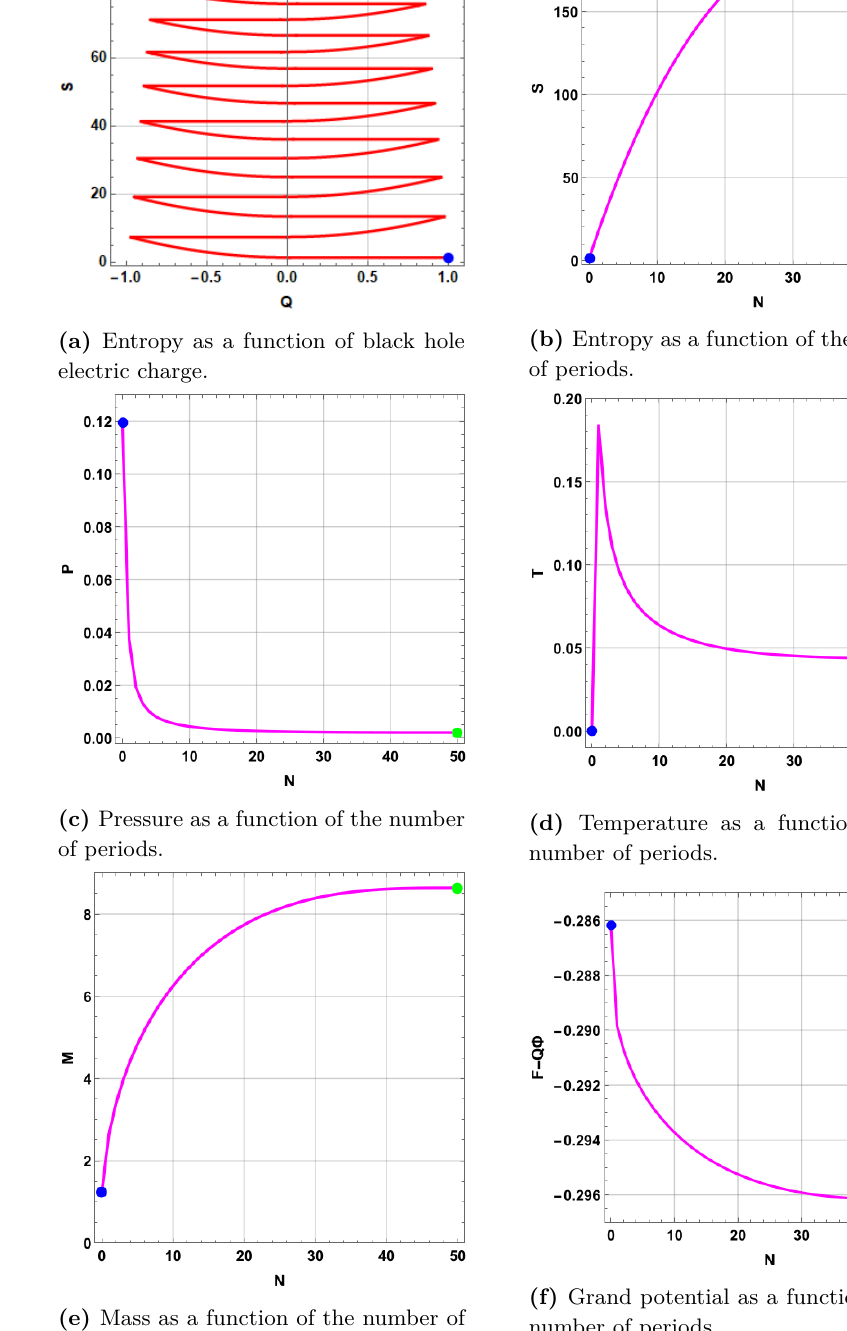
Figure 18. Evolution of different thermodynamical quantity during an isentropic neutralization with the absorption of 10 5 particles over 50 periods. The final state which is an AdS-Schwarzchild black hole is represented by a green dot. The initial conditions (blue dot) are Q = 1 , l = 1 , M = 1 . 23 , r h = 0 . 65 , and D = 4